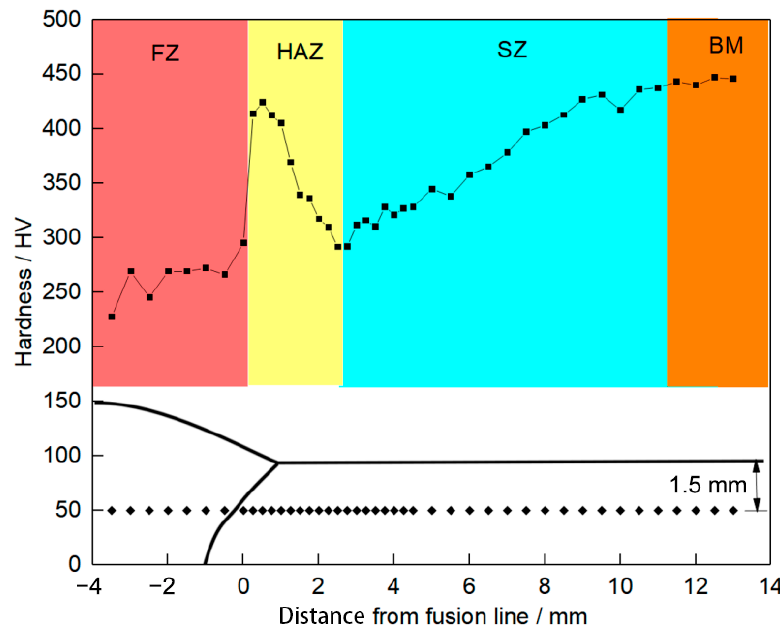
Figure 11. Microhardness distribution in the welded joint.